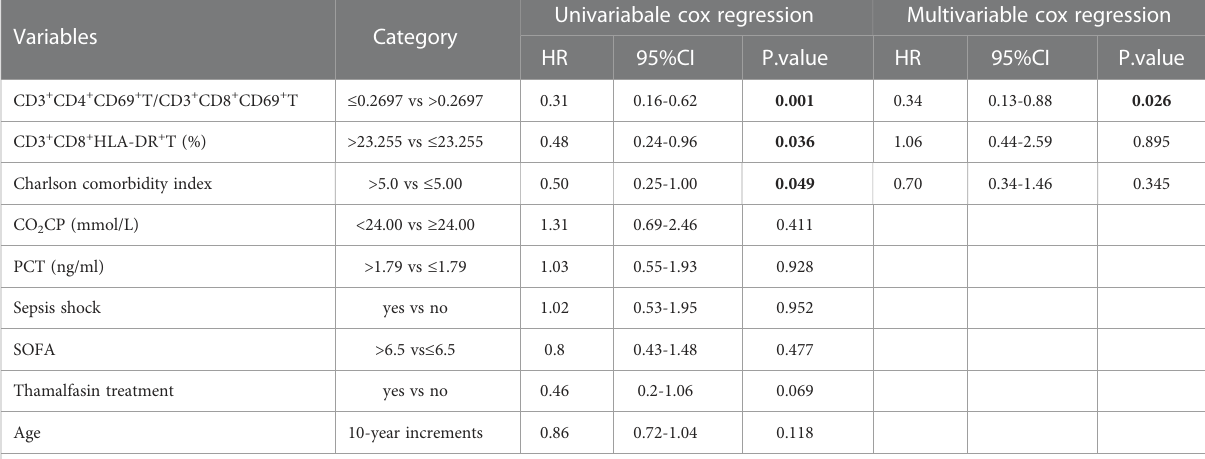
TABLE 6 Cox regression analysis of factors associated with the probability of ICU discharge for G - sepsis patients.